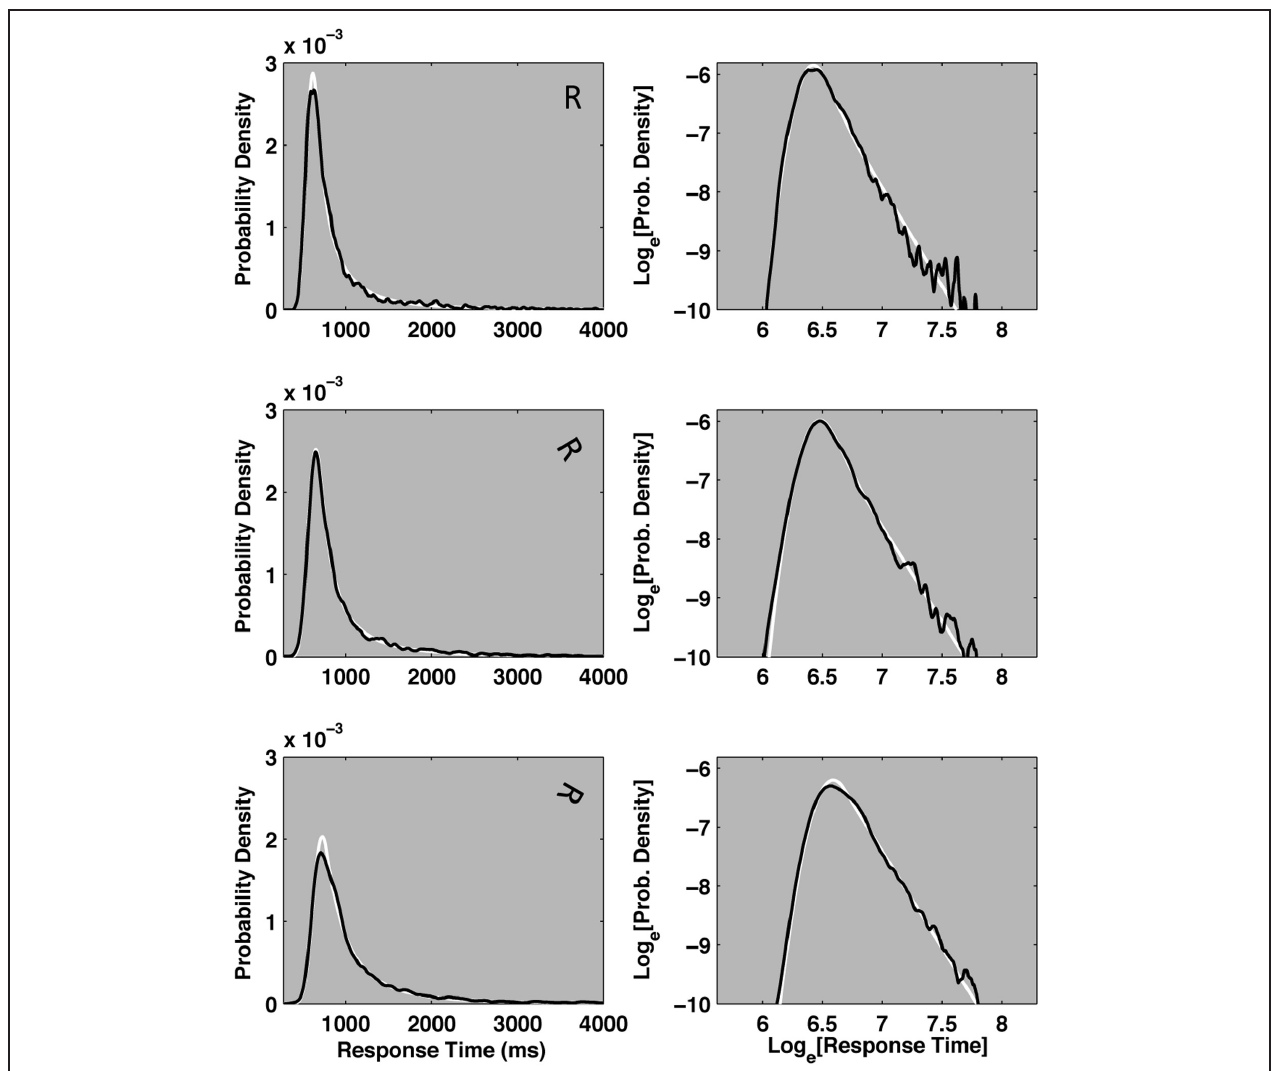
behind the empirical density functions. The three left-hand plots represent the response time distributions for normally oriented and 0 ◦ , 60 ◦ , and 120 ◦ rotated characters on linear axes. The three right-hand plots depict the same empirical and ideal cocktail distributions on double logarithmic axes, and make the power law decay of the distributions’ tails more apparent. All three conditions can be reasonably approximated by the cocktail distribution.